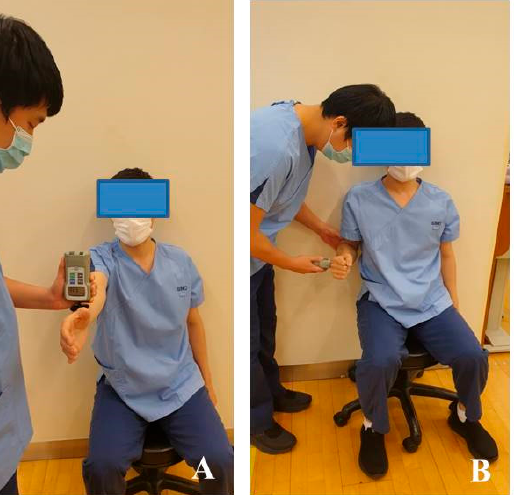
Figure 4. Measurement of muscle strength: ( A ) forward flexion; ( B ) external